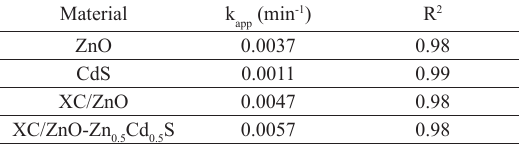
Table 3. Kinetic parameters obtained for the photodegradation tests. Material